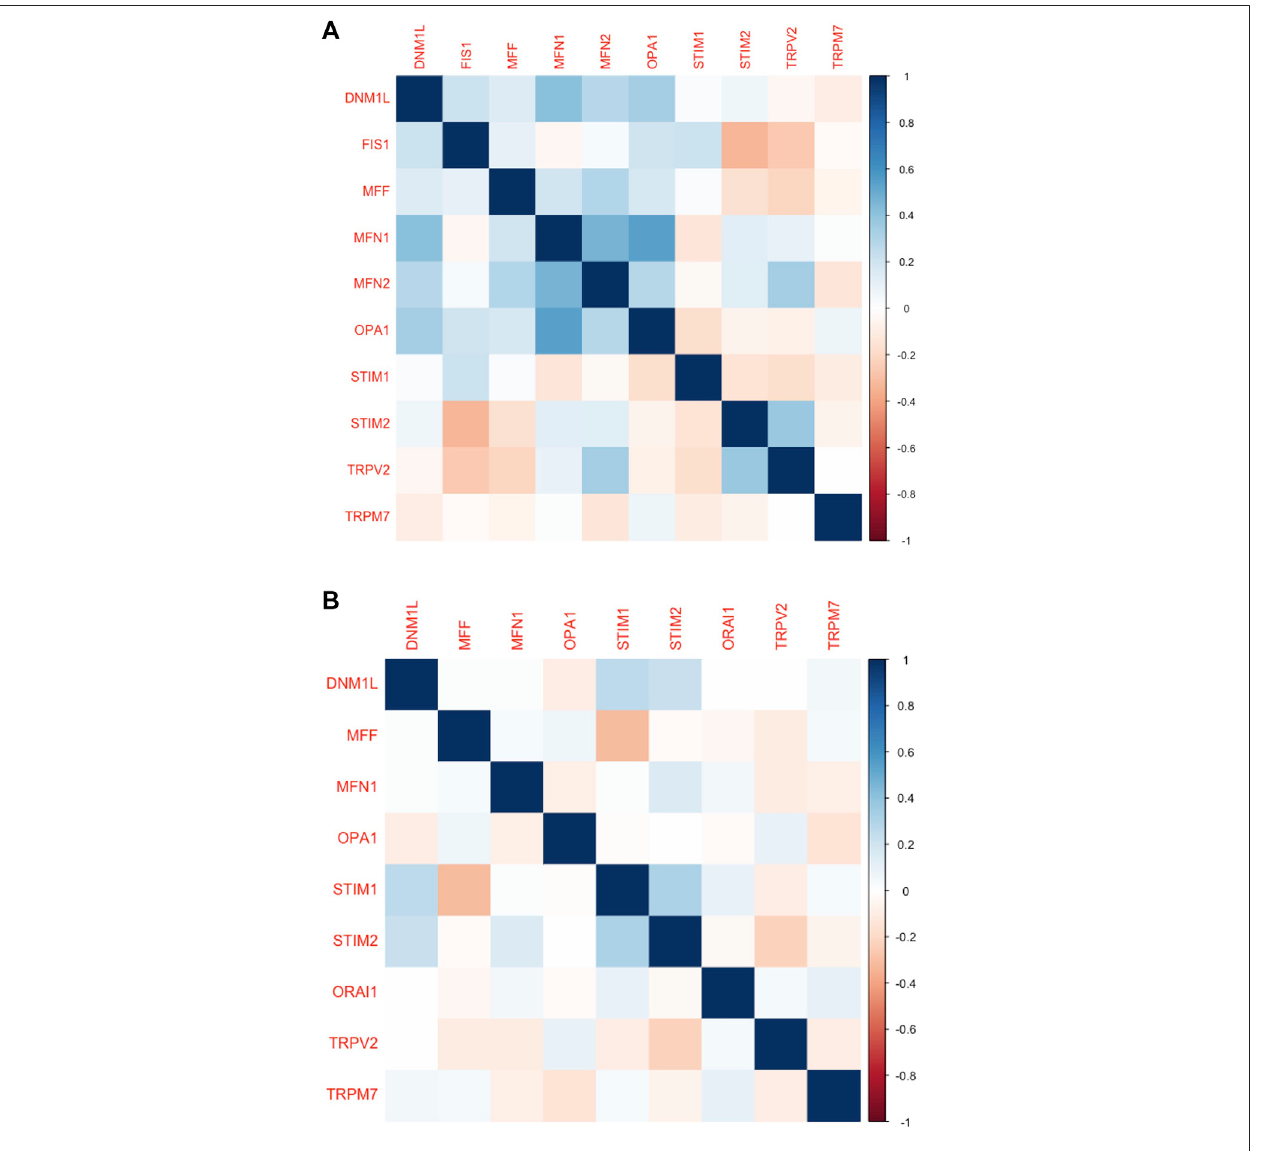
FIGURE 10 | Protein levels of SOCs correlated with the MDGs in HNSC. (A) The proteomics and (B) phospho-proteomics expression CPTAC-HNSC data was downloaded using Python 3.0. The correlation was calculated and plotted using Corr plot package for R programming. The markings on right hand side indicates the color code for correlation coef fi